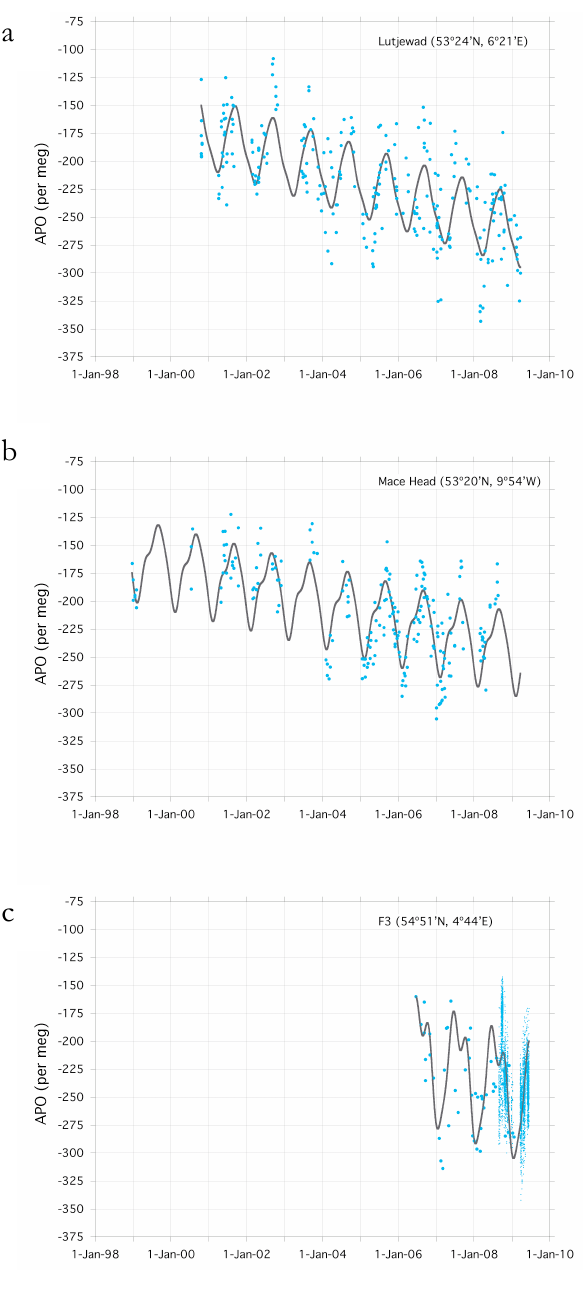
Fig. 6. Observations of the Atmospheric Potential Oxygen (APO) at station Lutjewad (a) , Mace Head (b) and F3 (c) during 1998– Figure 6 : Observations of the Atmospheric Potential Oxygen (APO) at station 2009, based on flask measurements (and continuous measurements Lutjewad (a), Mace Head (b) and F3 (c) during 2000-2009, based on flask for F3). The fits through the data points are a combination of a three measurements. The fits through the data points are a combination of a three harmonic function and a linear trend. harmonic function and a linear trend. 64 ± 6 per meg for Lutjewad, 74 ± 6 per meg for Mace Head and 111 ± 2 per meg for F3. The annual long term trend for each site is: − 10 . 6 ± 0 . 7 per meg/year for Lutjewad and − 8 . 4 ± 0 . 7 per meg/year for Mace Head. The data series for F3 is not long enough yet to provide precise information on the trend, which is roughly estimated at − 13 . 2 ± 0 . 5